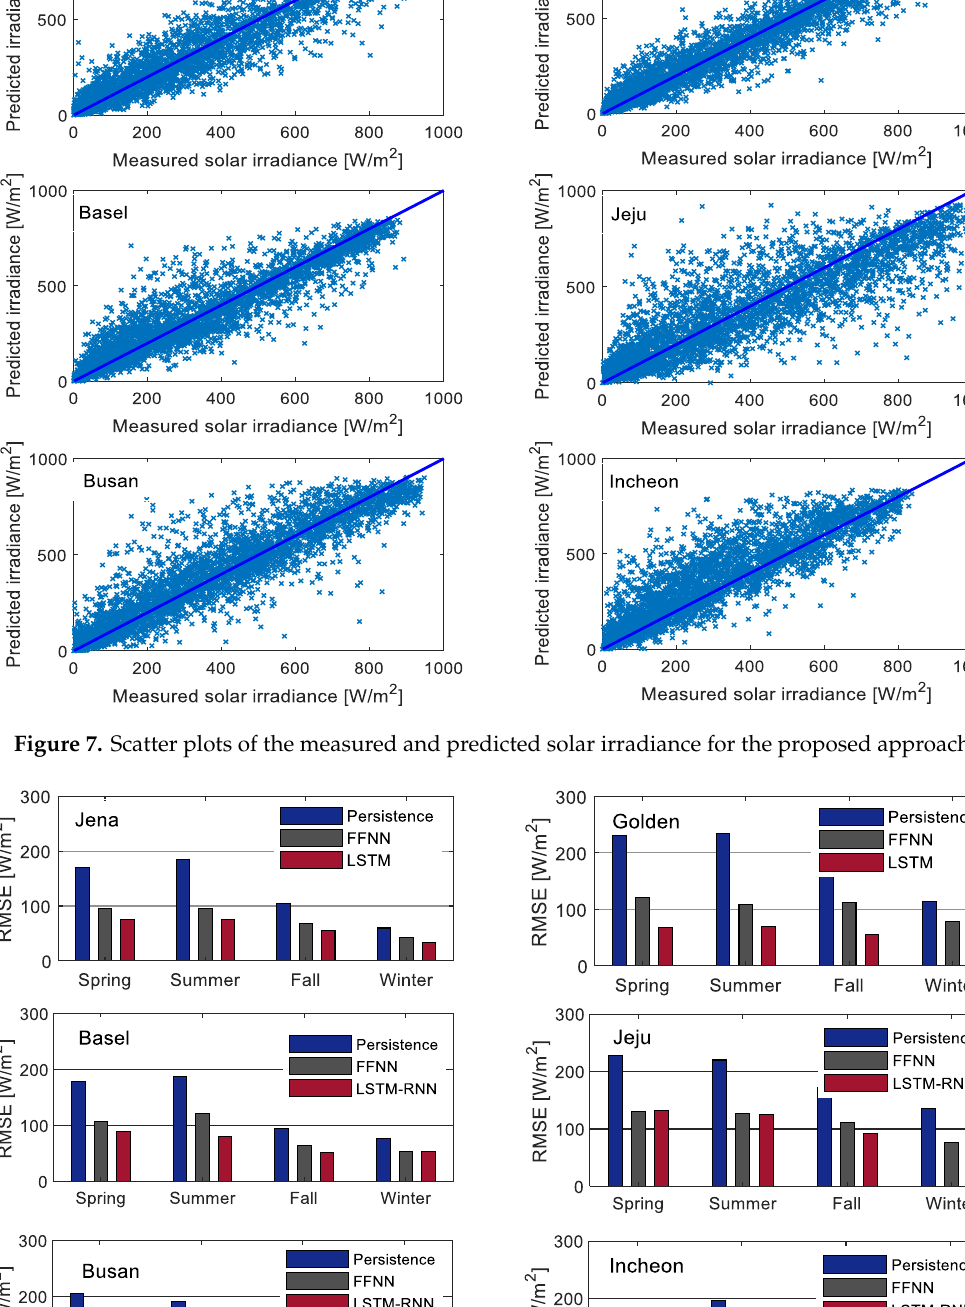
Figure 8. Comparison of seasonal RMSE of Persistence, FFNN, and LSTM models for the proposed approach.